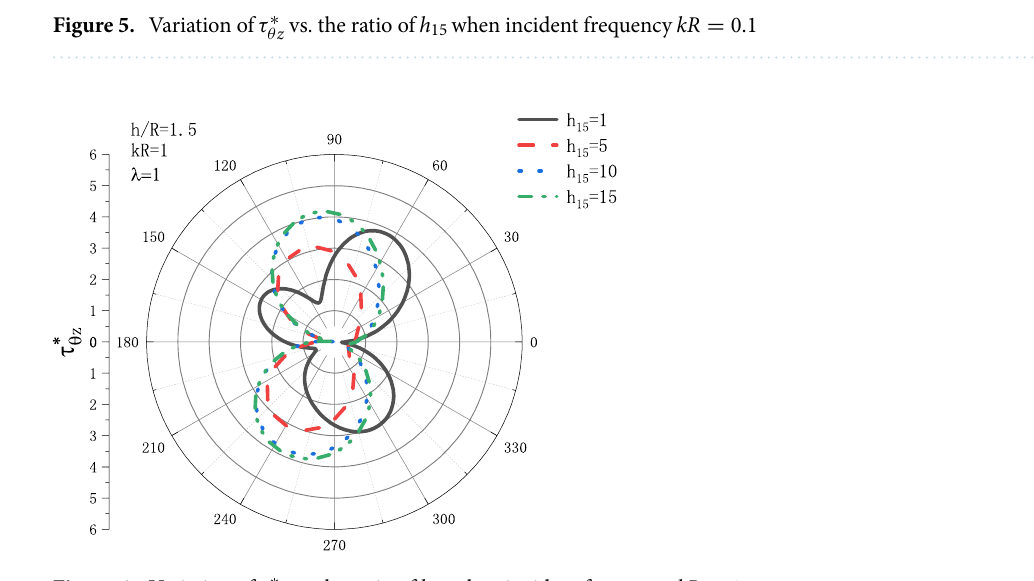
Figure 6. Variation of τ ∗ θ z vs. the ratio of h 15 when incident frequency kR = 1